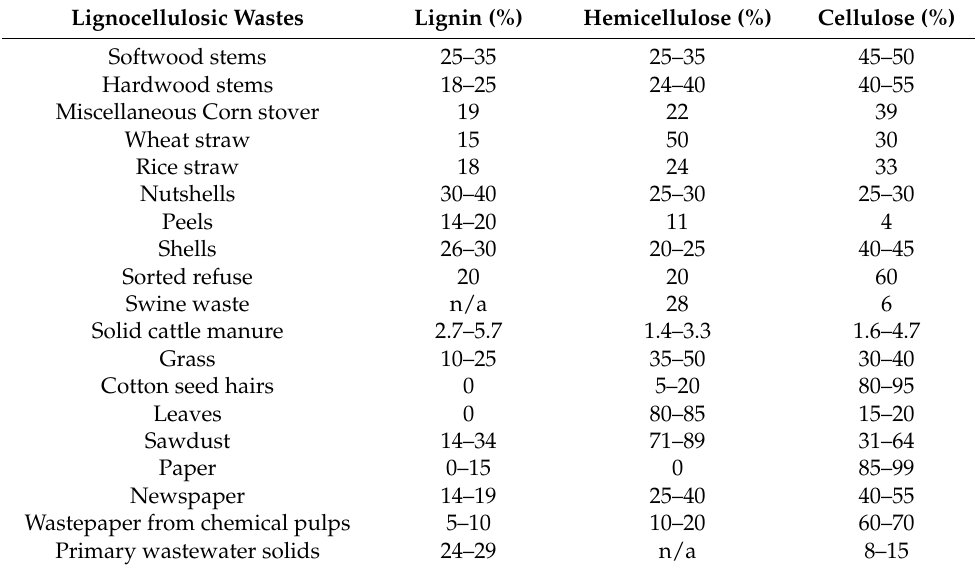
Table 4. Percentage content of most common lignocellulosic wastes [117,118]. Lignocellulosic